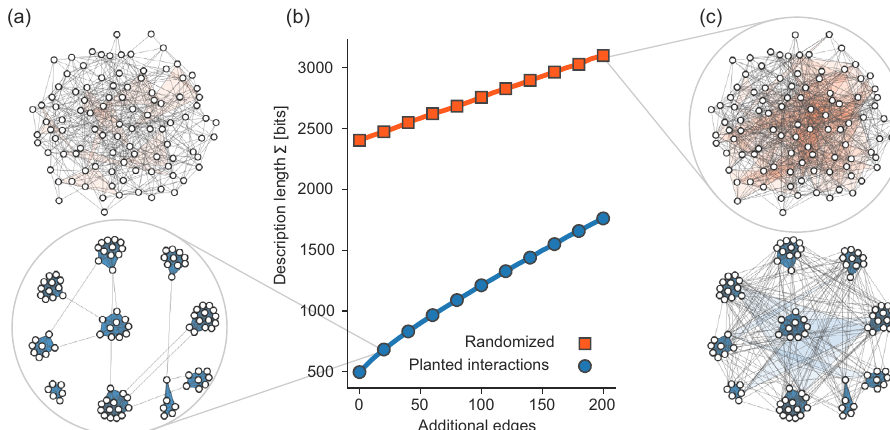
Fig. 3 Reconstruction in random networks with and without higher-order interactions. a Two networks, one obtained by projecting a hypergraph of ten disjoint hyperedges of unequal sizes (blue shades), and the other obtained by drawing uniformly from all networks with the same number of edges (orange shades). b Description length Σ of the networks as a function of the number of additional edges, chosen uniformly at random from the set of non-edges. c The two networks of panel ( a ), with 200 additional edges. In a , c , we show the group interactions uncovered by our method with shaded colors. The description lengths are averaged over ten independent realizations of the network generation and inference processes. Error bars of 1 standard deviations are too narrow to see with the naked